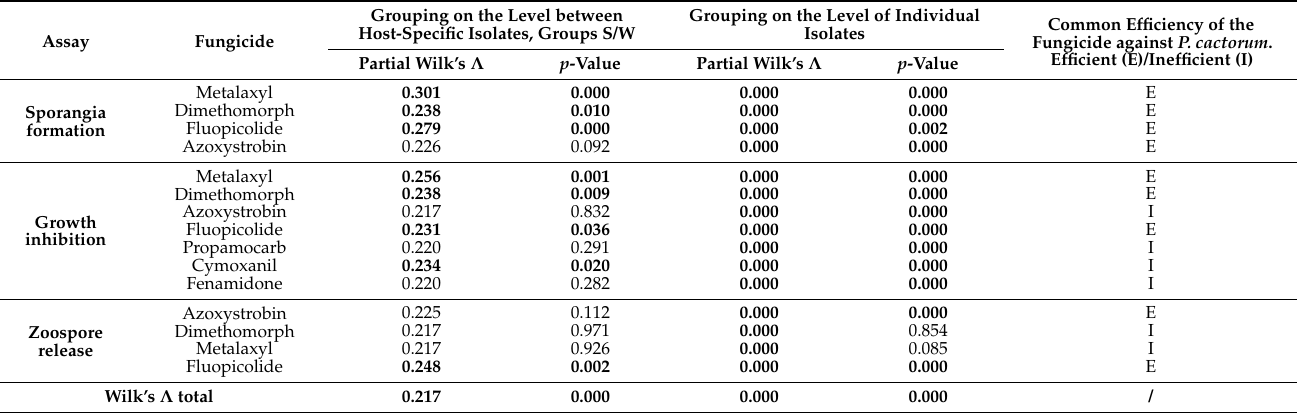
Table 5. Results of discriminant analysis of all performed assays for differentiation between S and W groups of P. cactorum isolates, based on in-vitro responses of isolates against the tested fungicides. Grouping on the Level between Grouping on the Level of Individual Host-Specific Isolates, Groups S/W Isolates Common Efficiency of the Fungicide against P. cactorum .